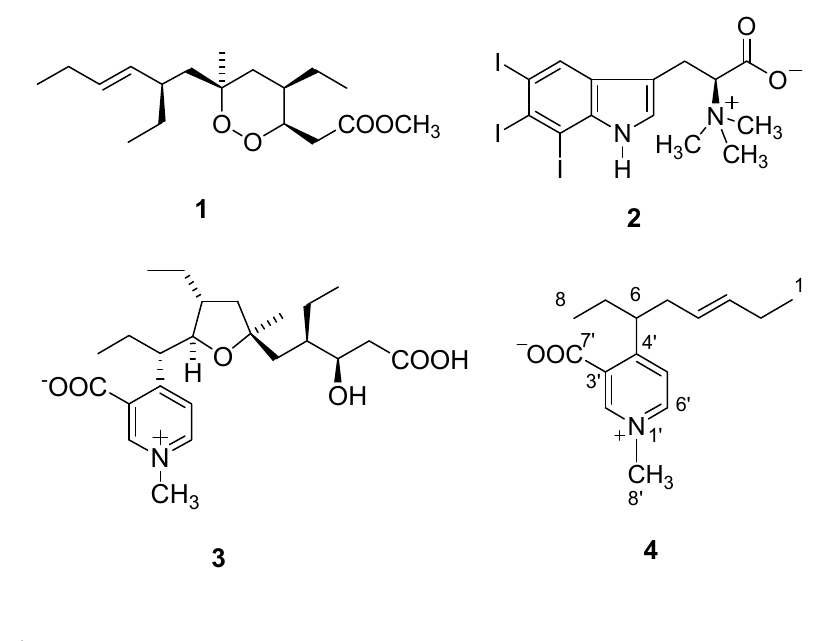
Figure 1. Representative molecules from Plakortis simplex , including the new simplexidine ( 4